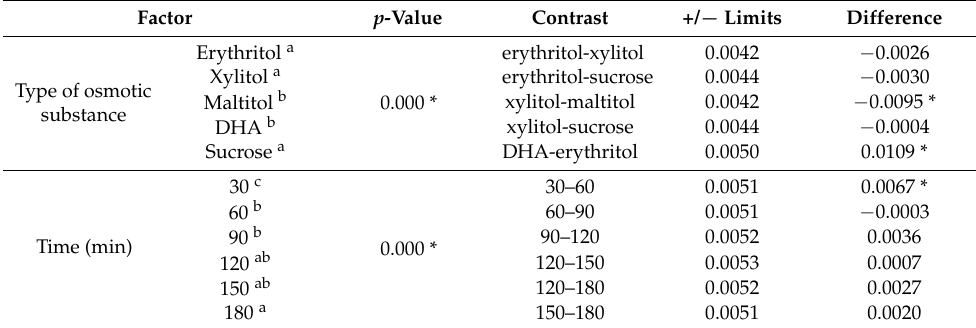
Figure 6. Water activity, a w , bars present the use of different solutions: erythritol ( ), xylitol ( ), maltitol ( ), dihydroxyacetone ( ), sucrose ( ). Dotted line is an initial a w of raw apple tissue. Table 11. The influence of osmotic agents and pre-treatment time on water activity during OD.